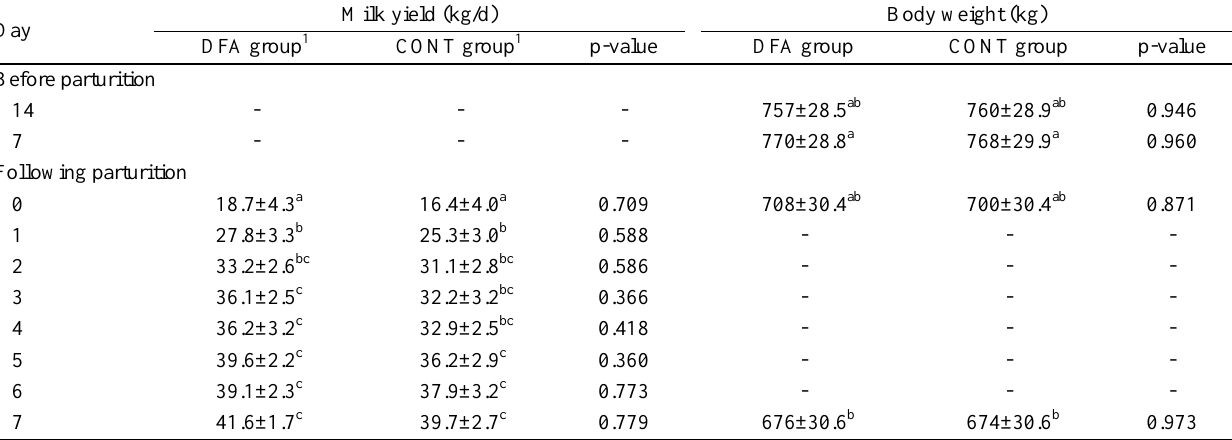
Table 4. Daily milk yield during first 7 d following parturition and weekly body weight changes before and following parturition periods relative to cows in DFA and CONT groups